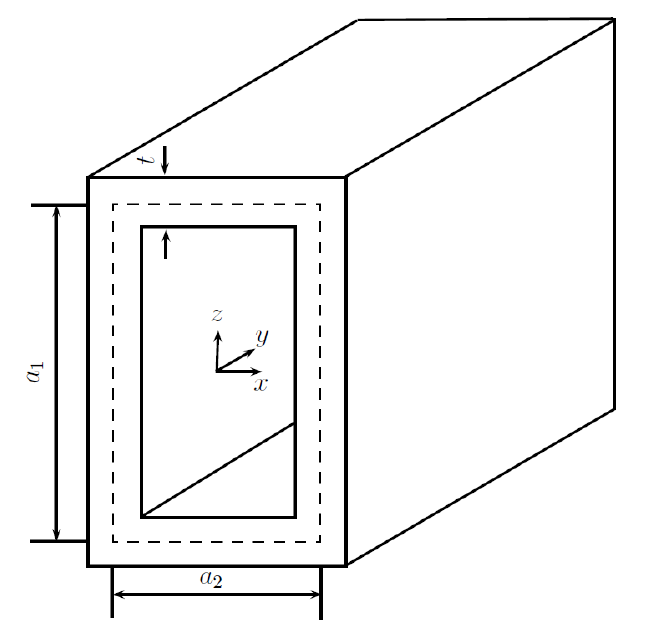
Figure 1. Thin-walled isotropic beam cross